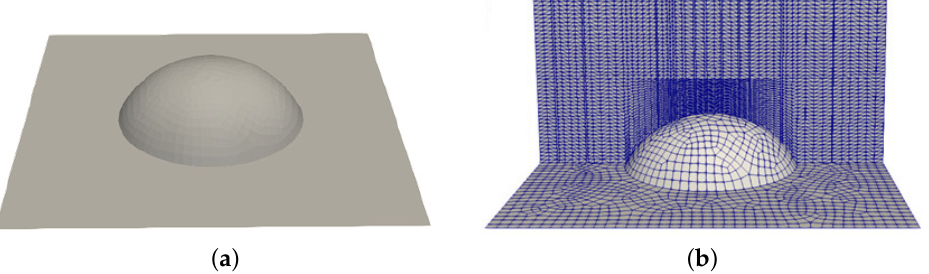
Figure 3. Representative domain near the wall: ( a ) geometry of the base (200 µ m × 200 µ m) with a dimple (D = 100 µ m; h = 30 µ m); ( b ) mesh close to the dimple at the